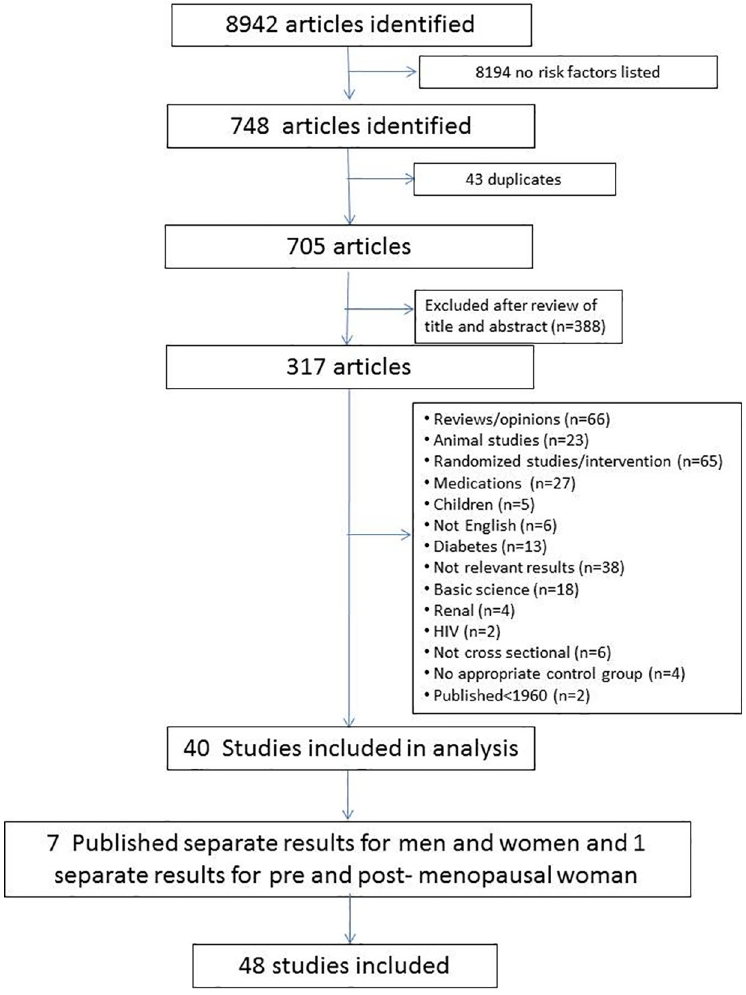
Fig 1. Study flow chart of meta-analysis of cross sectional